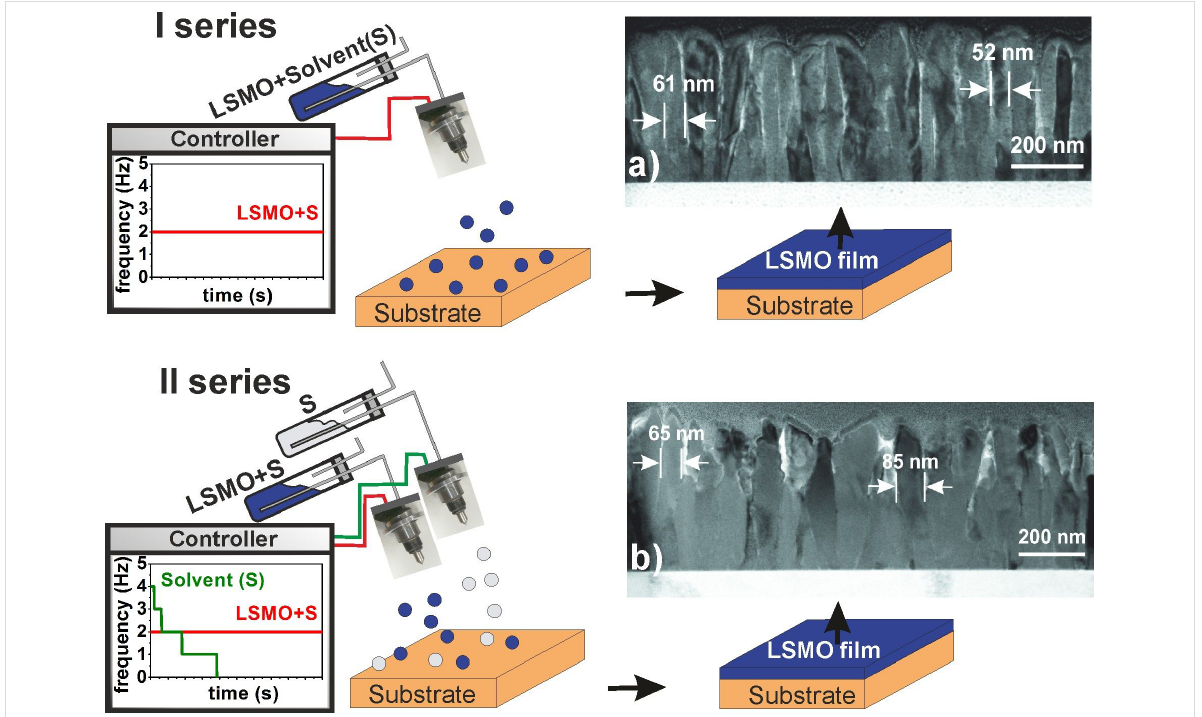
Figure 1: Schematic representation of the two deposition series of nanostructured LSMO films. I series – the mixture of precursors dissolved in the solvent is supplied to the reaction chamber. II series – 2 separate supply sources are used: i.) mixture of the precursor solution; ii.) solvent only, supplied in an exponentially decreasing manner leading to larger crystallites (TEM figures) and improved MR properties. (a, b) Cross-sectional TEM pictures of nanostructured LSMO films, for I and II deposition